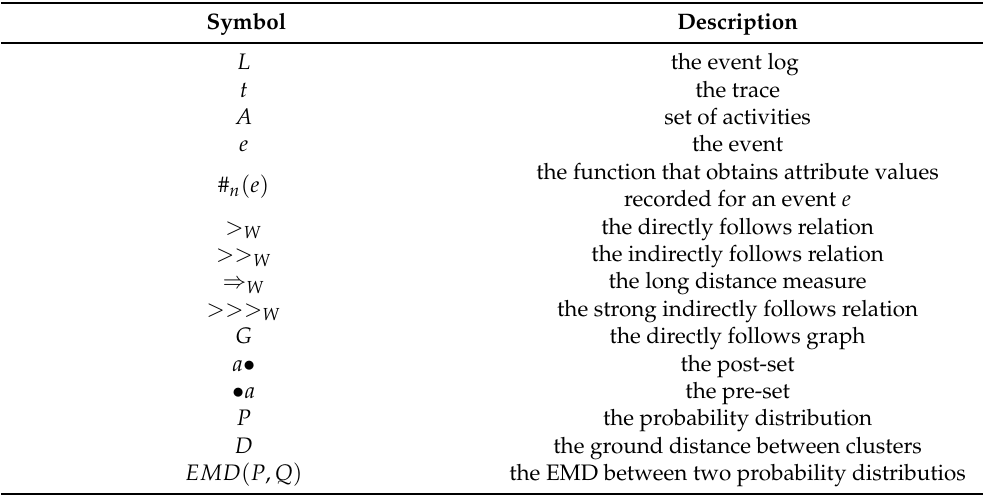
Table A1. Used notations in the